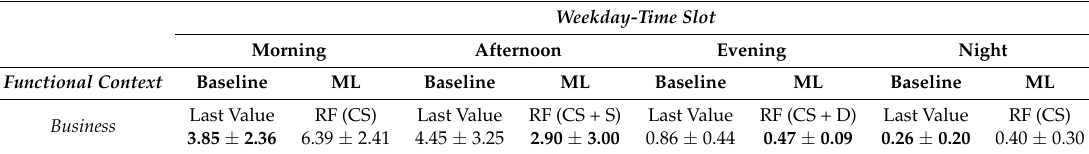
Table 4. Comparison between ML-based and baseline solutions in terms of MAE (avg ± std) for different time slots on weekend days.